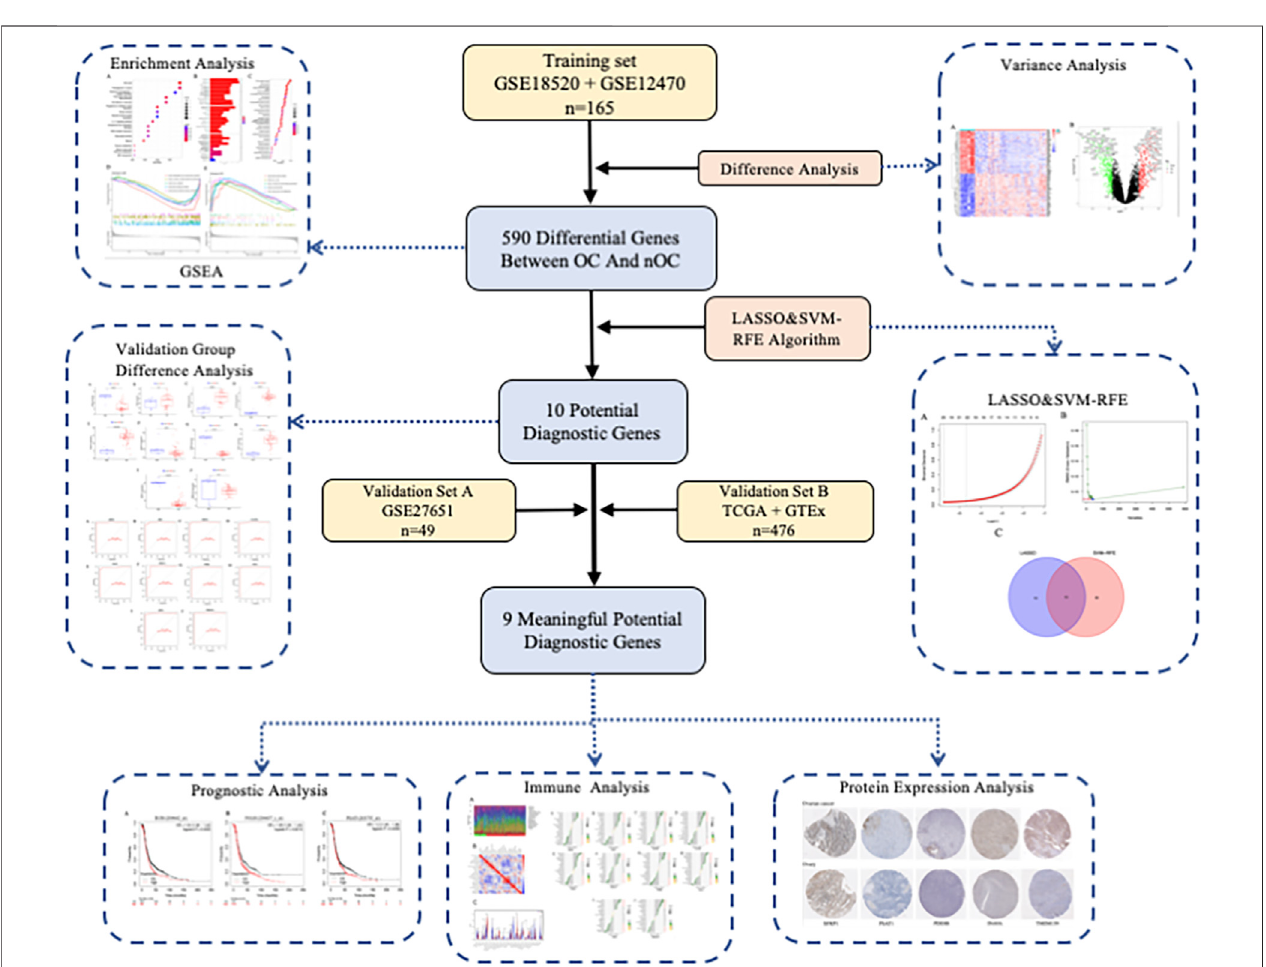
FIGURE 1 | Article framework and work fl